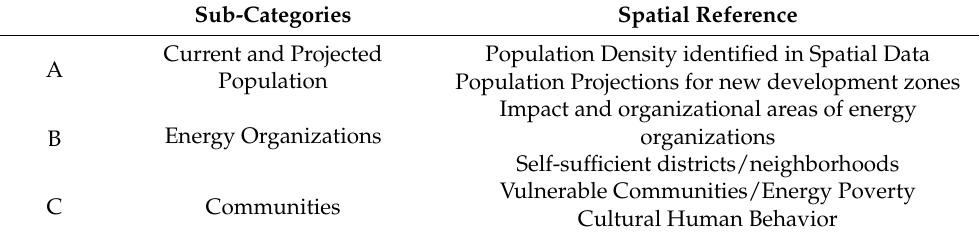
Table 6. Category 6: Social